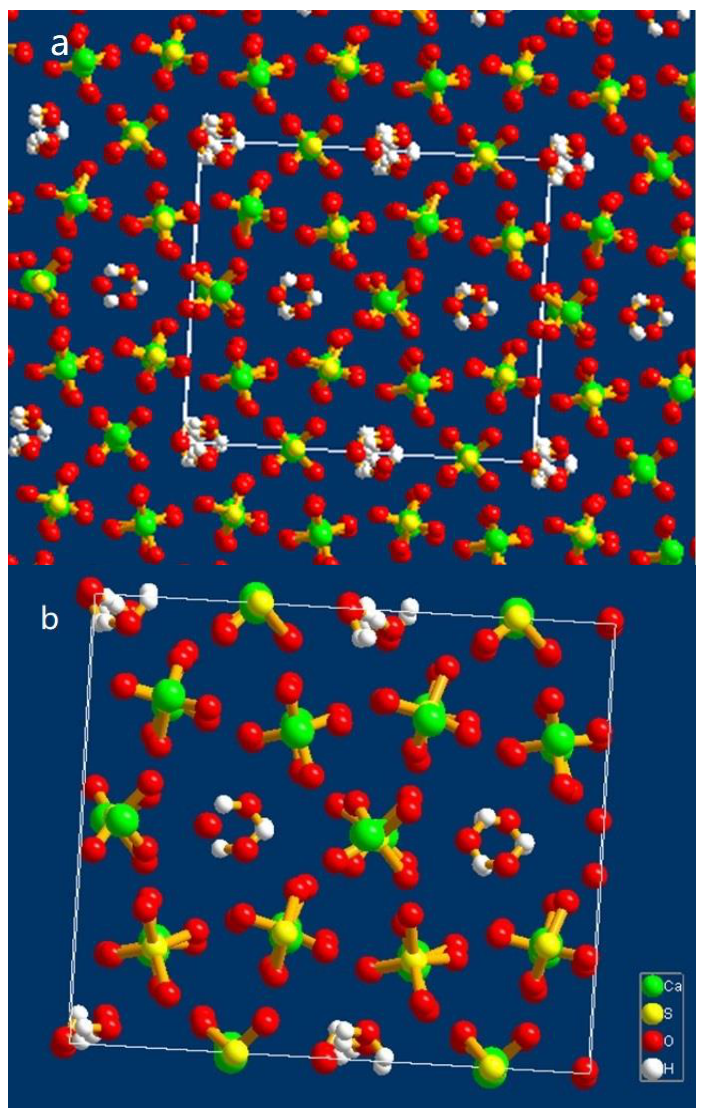
Figure 8. The crystal structure of α -HH along c -axis: ( a ) multiple cells; ( b ) unit cell. Here, the square box represents the unit cell edges.